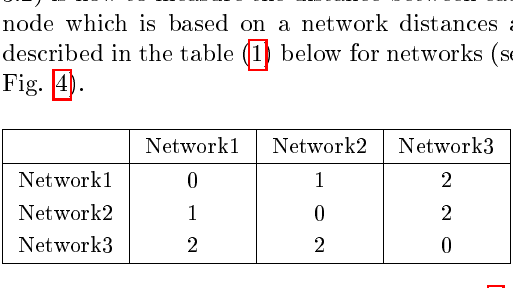
Tab. 1: Distance table for networks related to Fig. 4